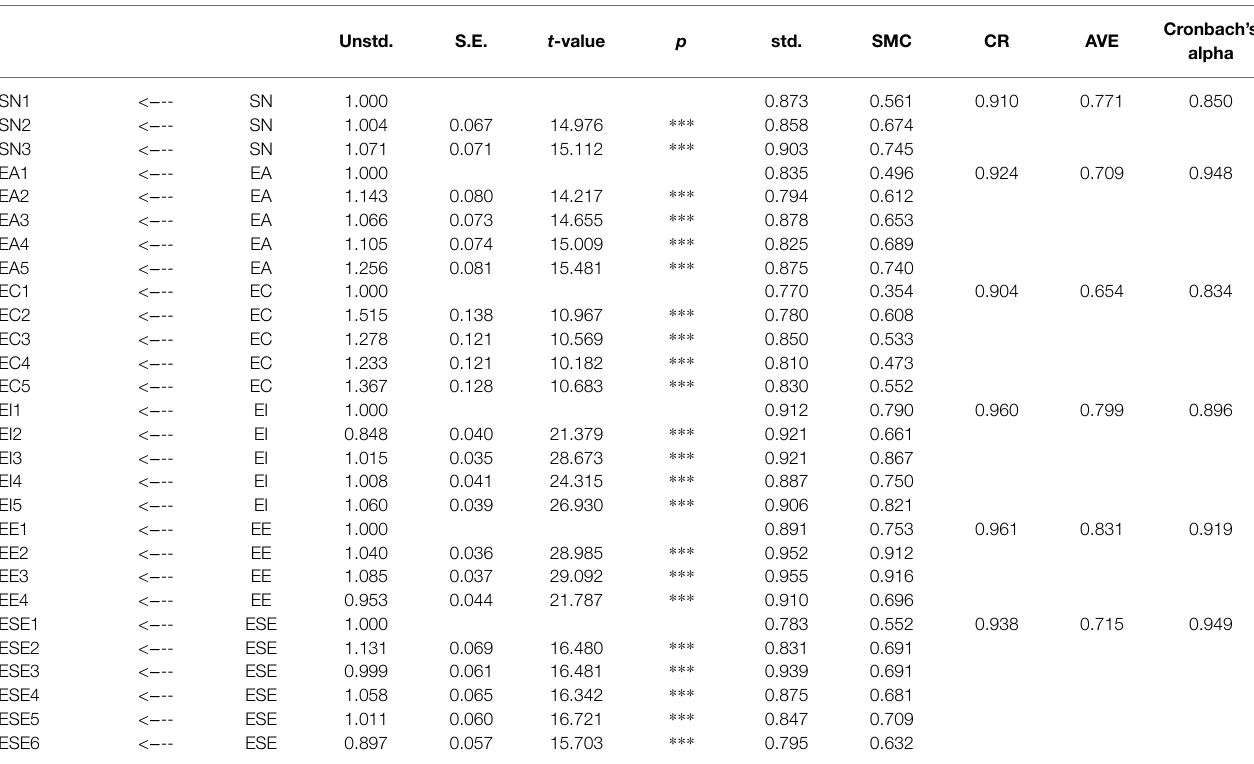
TABLE 4 | Convergence validity.